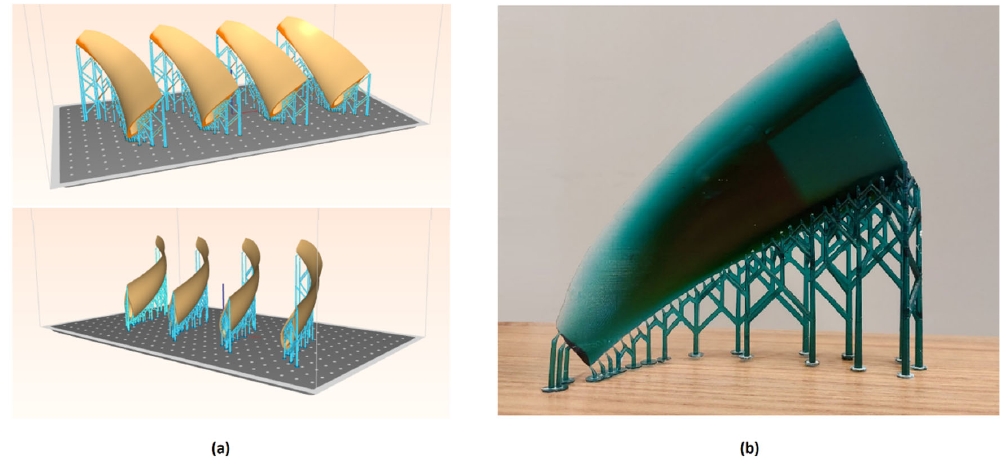
Figure 15. Model preparation and 3D printing. ( a ) Isometric slicer views, ( b ) 3D printed scaled down bladelet prototype (scale 1:20).